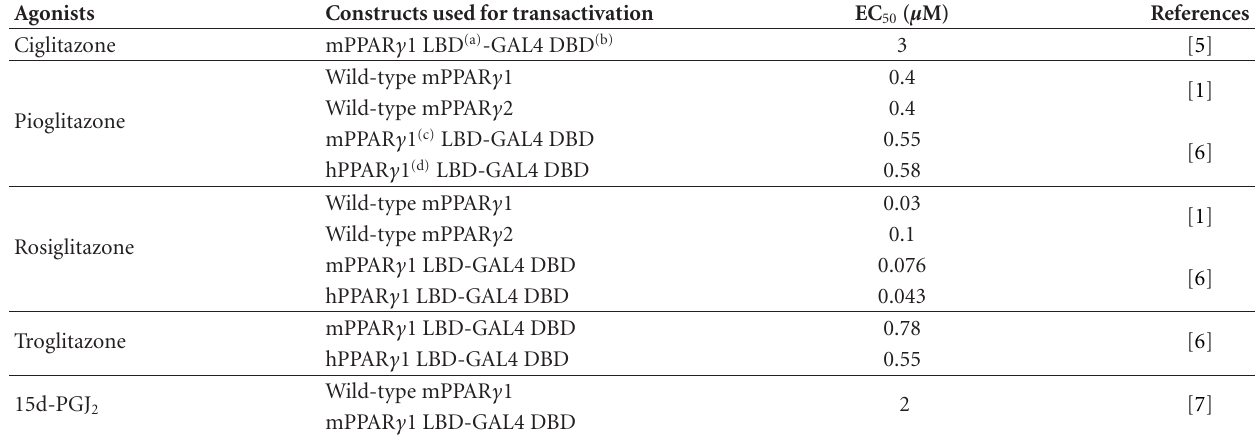
Table 1: EC 50 of common PPAR γ agonists in transactivation assays.